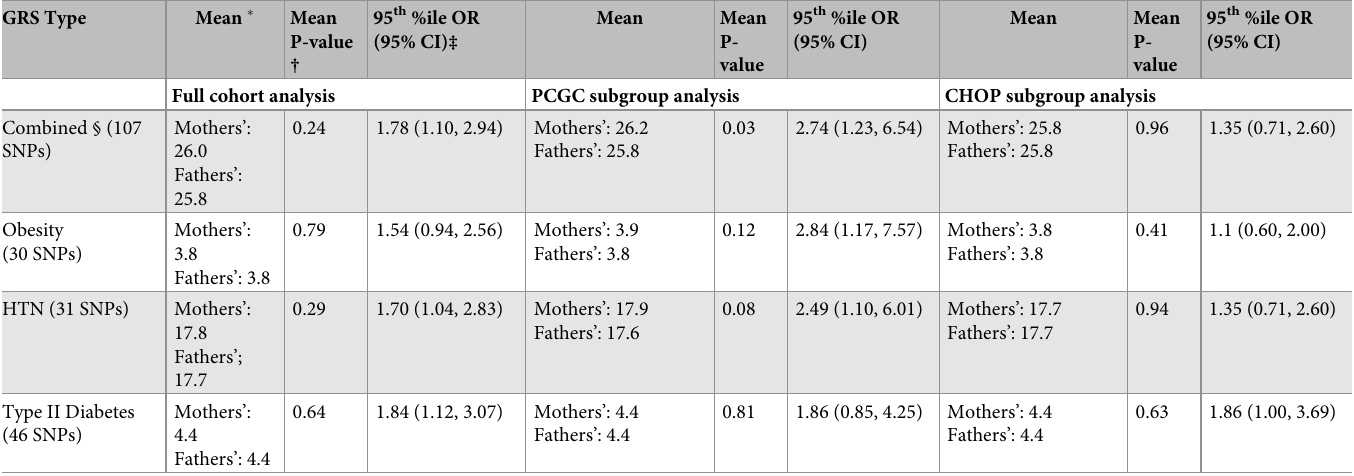
Table 3. Comparison of mothers’ versus fathers’ genetic risk scores (GRS) for adult conditions.